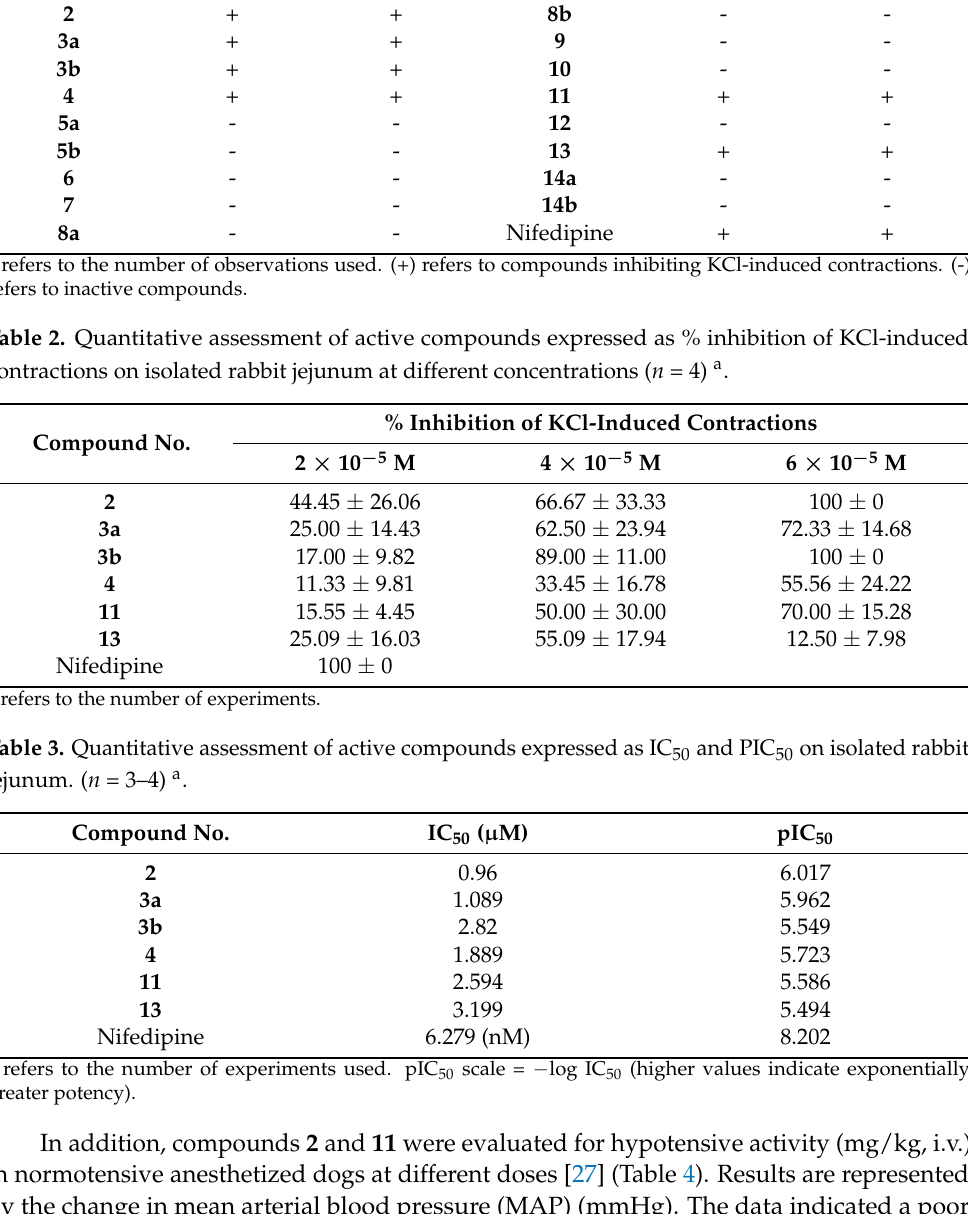
Table 1. Preliminary screening of calcium channel blocking activity of the tested compounds at a concentration of 10 − 5 M in DMSO on isolated rat colon and rabbit jejunum ( n = 4) a . Rabbit Cpd No. Cpd No. Rat Colon Jejunum